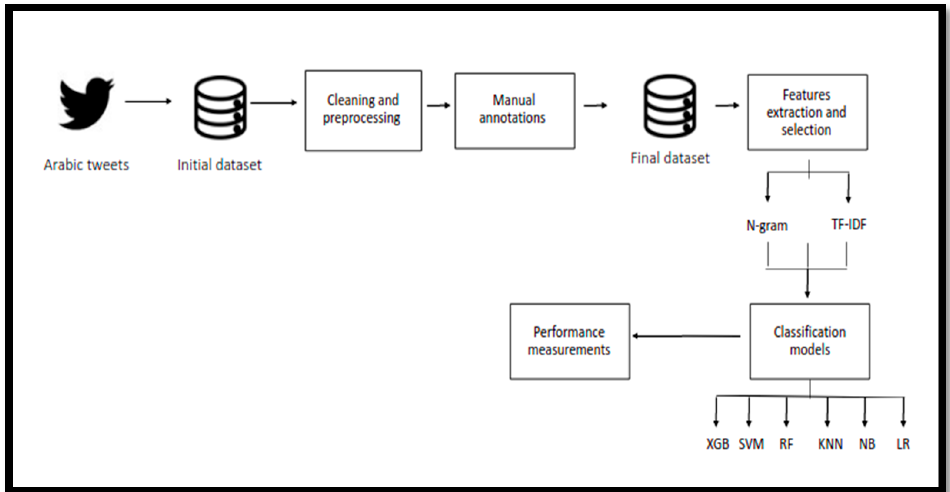
Figure 1. Research